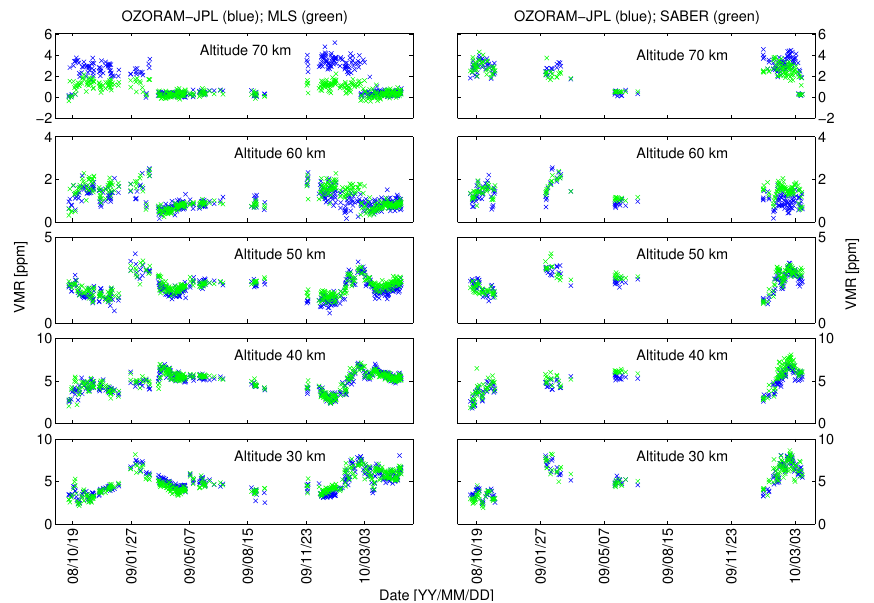
Fig. 8. Time series of the OZORAM-JPL data set versus MLS data (left panels) and SABER data (right panel). Plotted are matching pairs, the satellite data have been smoothed according to Eq. (9). See Fig. 9 for details on the correlation of the values retrieved in each altitude. The comparison shows (in conjunction with Fig. 5b), that measurements up to 70km altitude can be used to observe changes in the O 3 VMR.